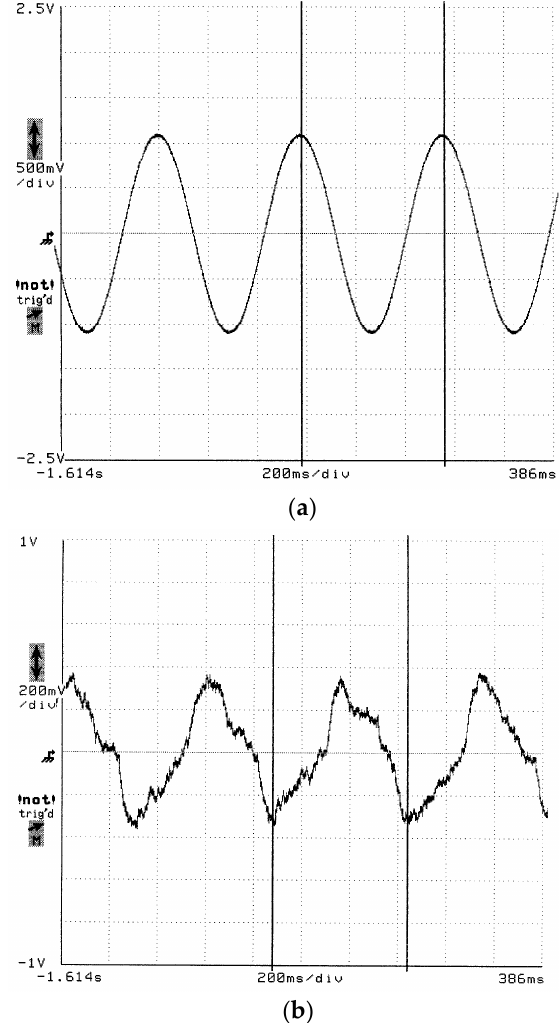
Figure 8. Oscilloscope traces showing the response of a sensor FFPI on a Styrofoam sheet: ( a ) dis- turbed signal applied to the speaker for modulation; ( b ) extracted signal from the optical receiver.